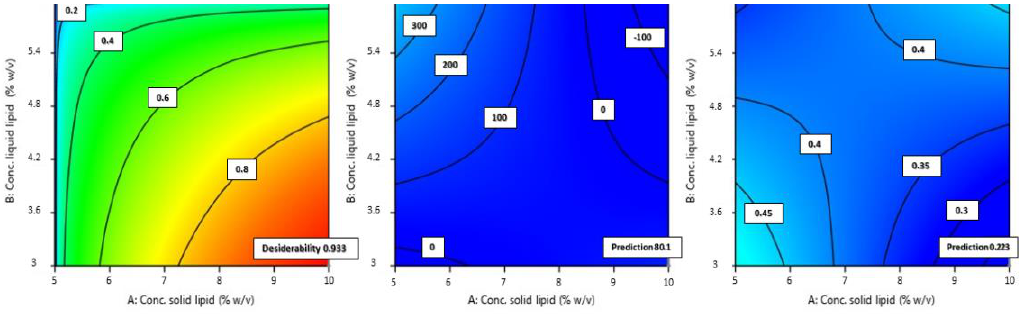
Figure 6. Contour plot of optimized formulation in terms of desirability, size, and PDI (from left to right).